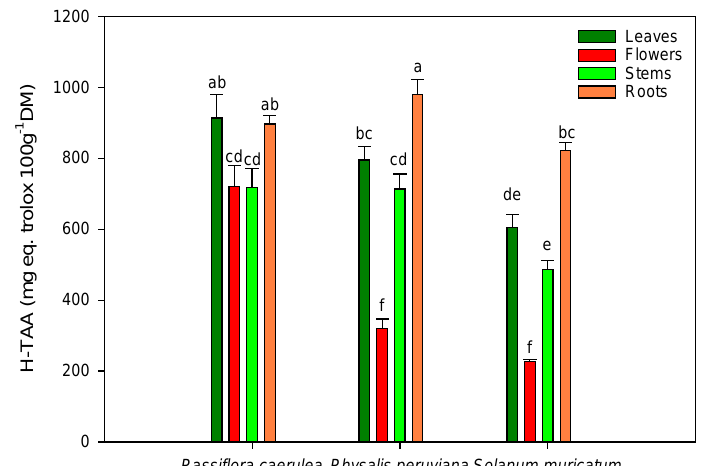
Figure 1. Antioxidant activity of the different parts of Passiflora caerulea L., Physalis peruviana L. and Solanum muricatum Aiton in the hydrophilic soluble phase. Different letters on the bars indicate significant differences at a p < 0.05 level of probability. Data are the mean ± standard error (SE).